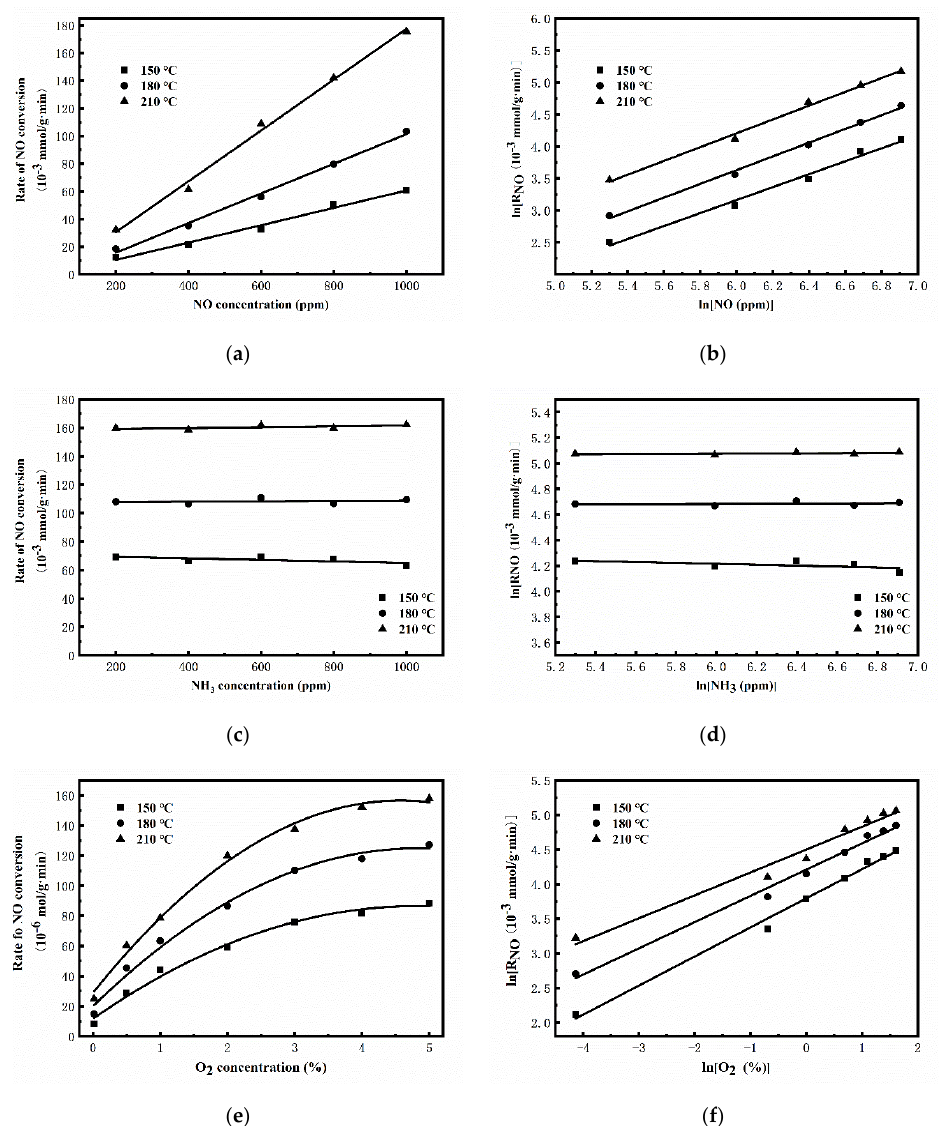
Figure 2. NO conversion rate as a function of concentration of NO ( a , b ), NH 3 ( c , d ), O 2 ( e , f ) in linear and corresponding logarithmic scales. The other reaction conditions are fixed at 50 mg of catalyst, 3000 mL/min of total flow rate, and temperatures 150–210 °C.